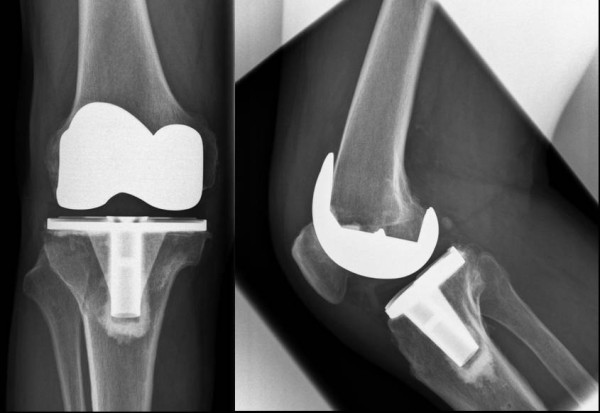
Implantation of a NexGen LPS TKA after previous closed-wedge osteotomy. The roentgenograms at the latest follow-up show good alignment and patella baja.